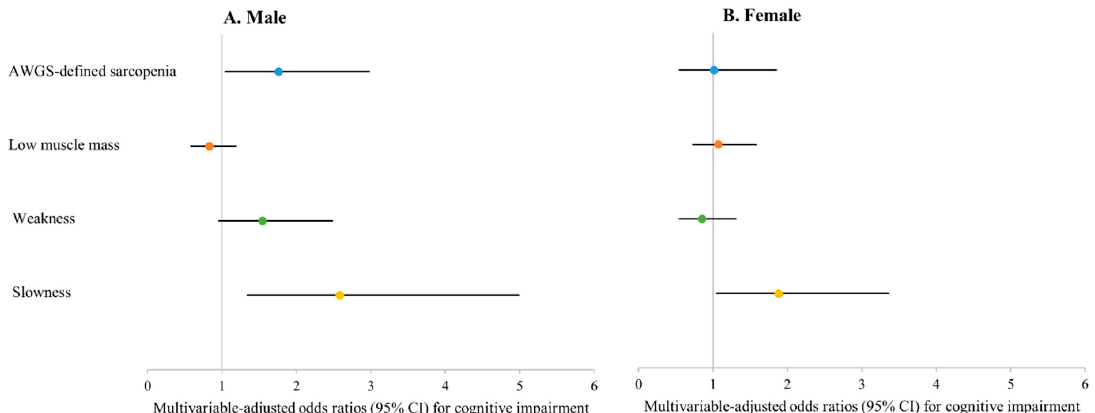
Figure 2. ( A ) Male; ( B ) Female. Associations between sarcopenia, its defining components, and cognitive impairment. Model 3: Adjusted for age, education, smoking status, alcohol intake, Mini Nutritional Assessment Screening score ( ≤ 11), low physical activity, body mass index, number of comorbidities, depressive symptoms, and self-reported health status (good vs. poor). Cognitive impairment was defined as a score greater than 1.5 of standard deviation below the corresponding age, sex and education-based Korean norms in any of the four cognitive domains (processing speed, executive function, verbal episodic memory, and working memory).